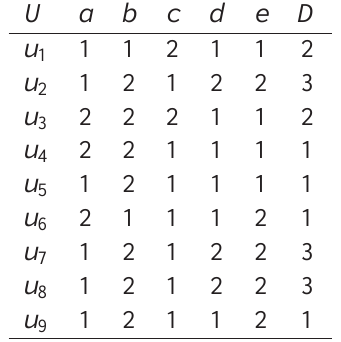
Table 5: The induced consistent decision system S